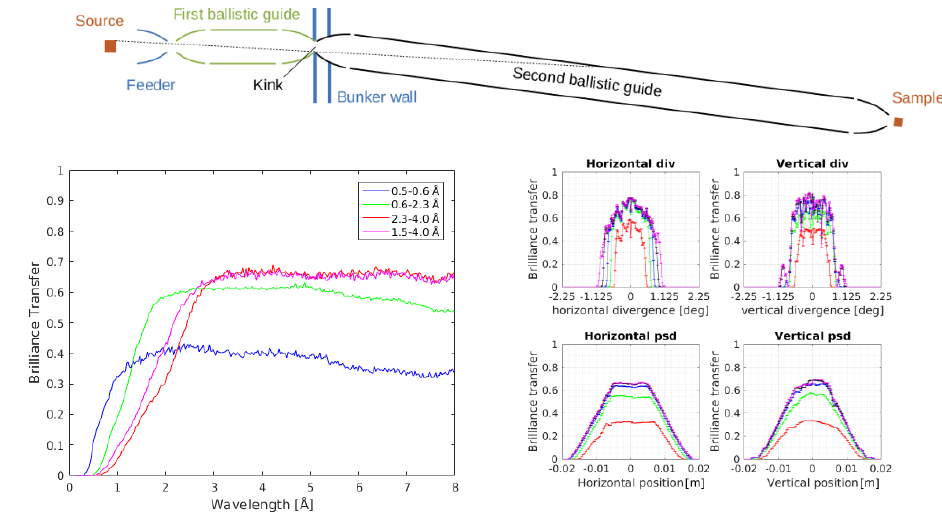
Figure 5. Kinked guide. Performance of coating-optimized kinked guides. Top: Schematic drawing of the kinked guide: the double-pinhole guide, where the direct line-of-sight from the moderator is broken by a kink between the two elliptical guides. The position where line-of-sight is broken depends on the kink angle. The figure is not to scale. The bottom panels show the performance of coating-optimized kinked guides. Left: Simulated values of BT ( λ ) as a function of neutron wavelength optimized for coating value and geometry for the wavelength bands WB1 (blue), WB2 (green), WB3b (purple), and WB3a (red), using a pinhole size of height × width = 5 × 3 cm 2 . Right: Integrated BT of the kinked guide, optimized for WB3b, 1.5–4.0 Å. The panels show the BT as a function of horizontal/vertical position and divergence for different wavelengths marked by colors. (red: 1.5 Å, green: 2.1 Å, blue: 2.8 Å, black: 3.4 Å, purple: 4.0